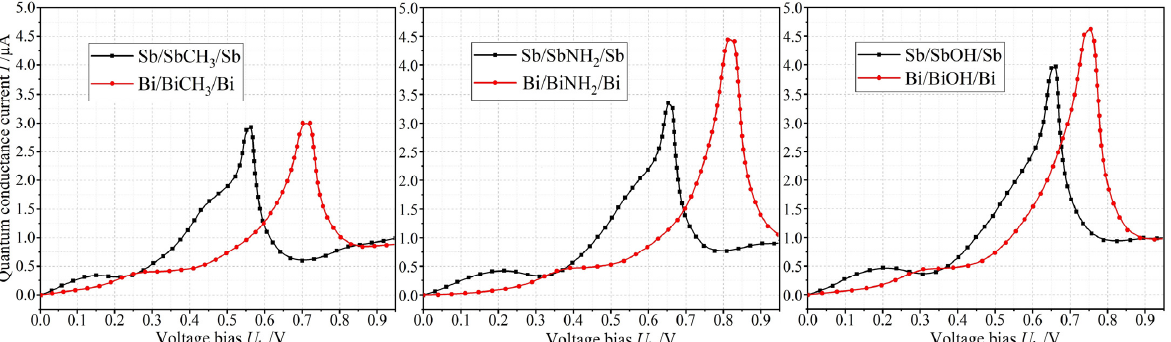
Figure 5. Quantum conductance I-U b characteristics of resonant tunneling transistors modeled by Sb/SbXH n /Sb and Bi/BiXH n /Bi double-heterostructures of monolayer zigzag nanoribbons. When U b is lower than threshold voltage ( U th = 0.3~0.4 V), the quantum conductance current is still smaller than 1 µA. With the increase of U b , the Fermi level contributed by topological edge-states of Sb or Bi monolayer nanoribbon segment in the relatively low electric potential area (source region) elevates gradually in these double-heterostructure